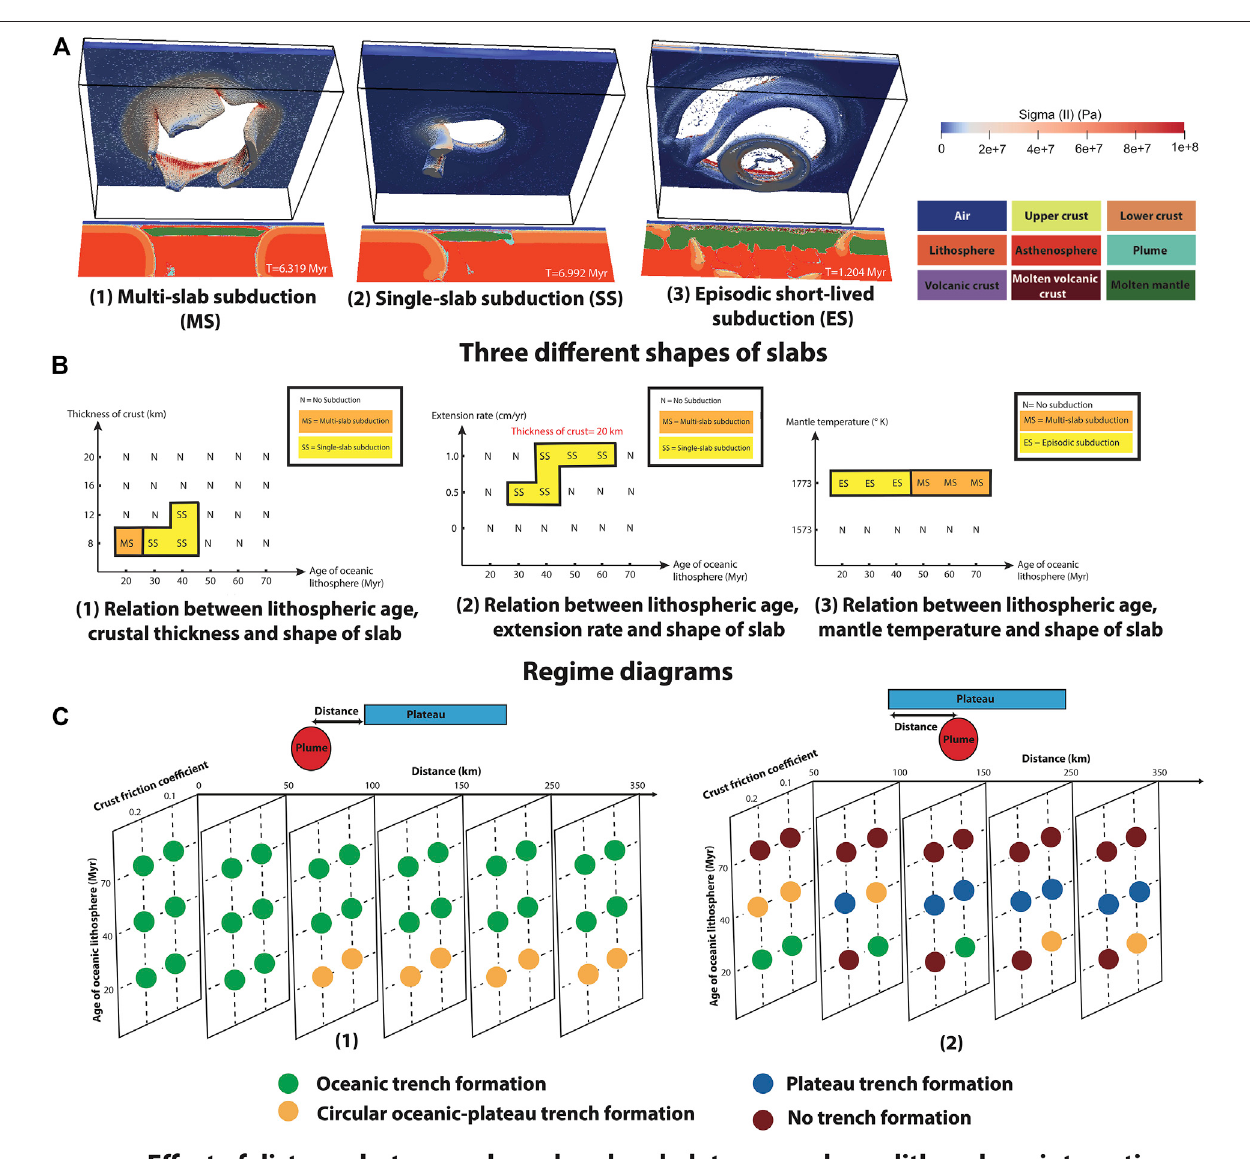
FIGURE 8 | (A,B) Modeling results of Baes et al. (2020a) exploring controlling factors in the shape and number of slabs. (A) Three different styles of subduction initiation induced by plume-lithosphere interaction: (1) multi-slab subduction, (2) single-slab subduction, (3) episodic short-lived subduction. The 2D cross-section showsthematerialphasesatacross-sectionthroughthemiddleofthemodel(colorcodesareshownontheright).The3D fi guresillustratethesecondinvariantofstress tensor of the lithospheric part of the model. (B) Summary of results: diagrams show the dependency of the number of slabs formed due to plume-lithosphere interaction on (1) lithospheric age and crust thickness, (2) lithospheric age and extension rates, (3) lithospheric age and plume temperature. Diagrams shown in (2) and (3) demonstrateresults ofmodelswith20 kmthick crust.In alldiagrams SS,MSandESstandforsingle-slab, multi-slab and episodicsubductioninitiation, respectively. (C) ModelresultsofBaesetal.(2020b)inwhichtheeffectofdistancebetweenplumeheadandplateauwasinvestigated.Figureshowsthatthemaincontrollingfactorsin deformation regimesarethe relative locations ofplateau and plume head and ageofoceanic lithosphere.Intheseexperiments thebuoyancy oftheplume,whichcan be another governing factor, was